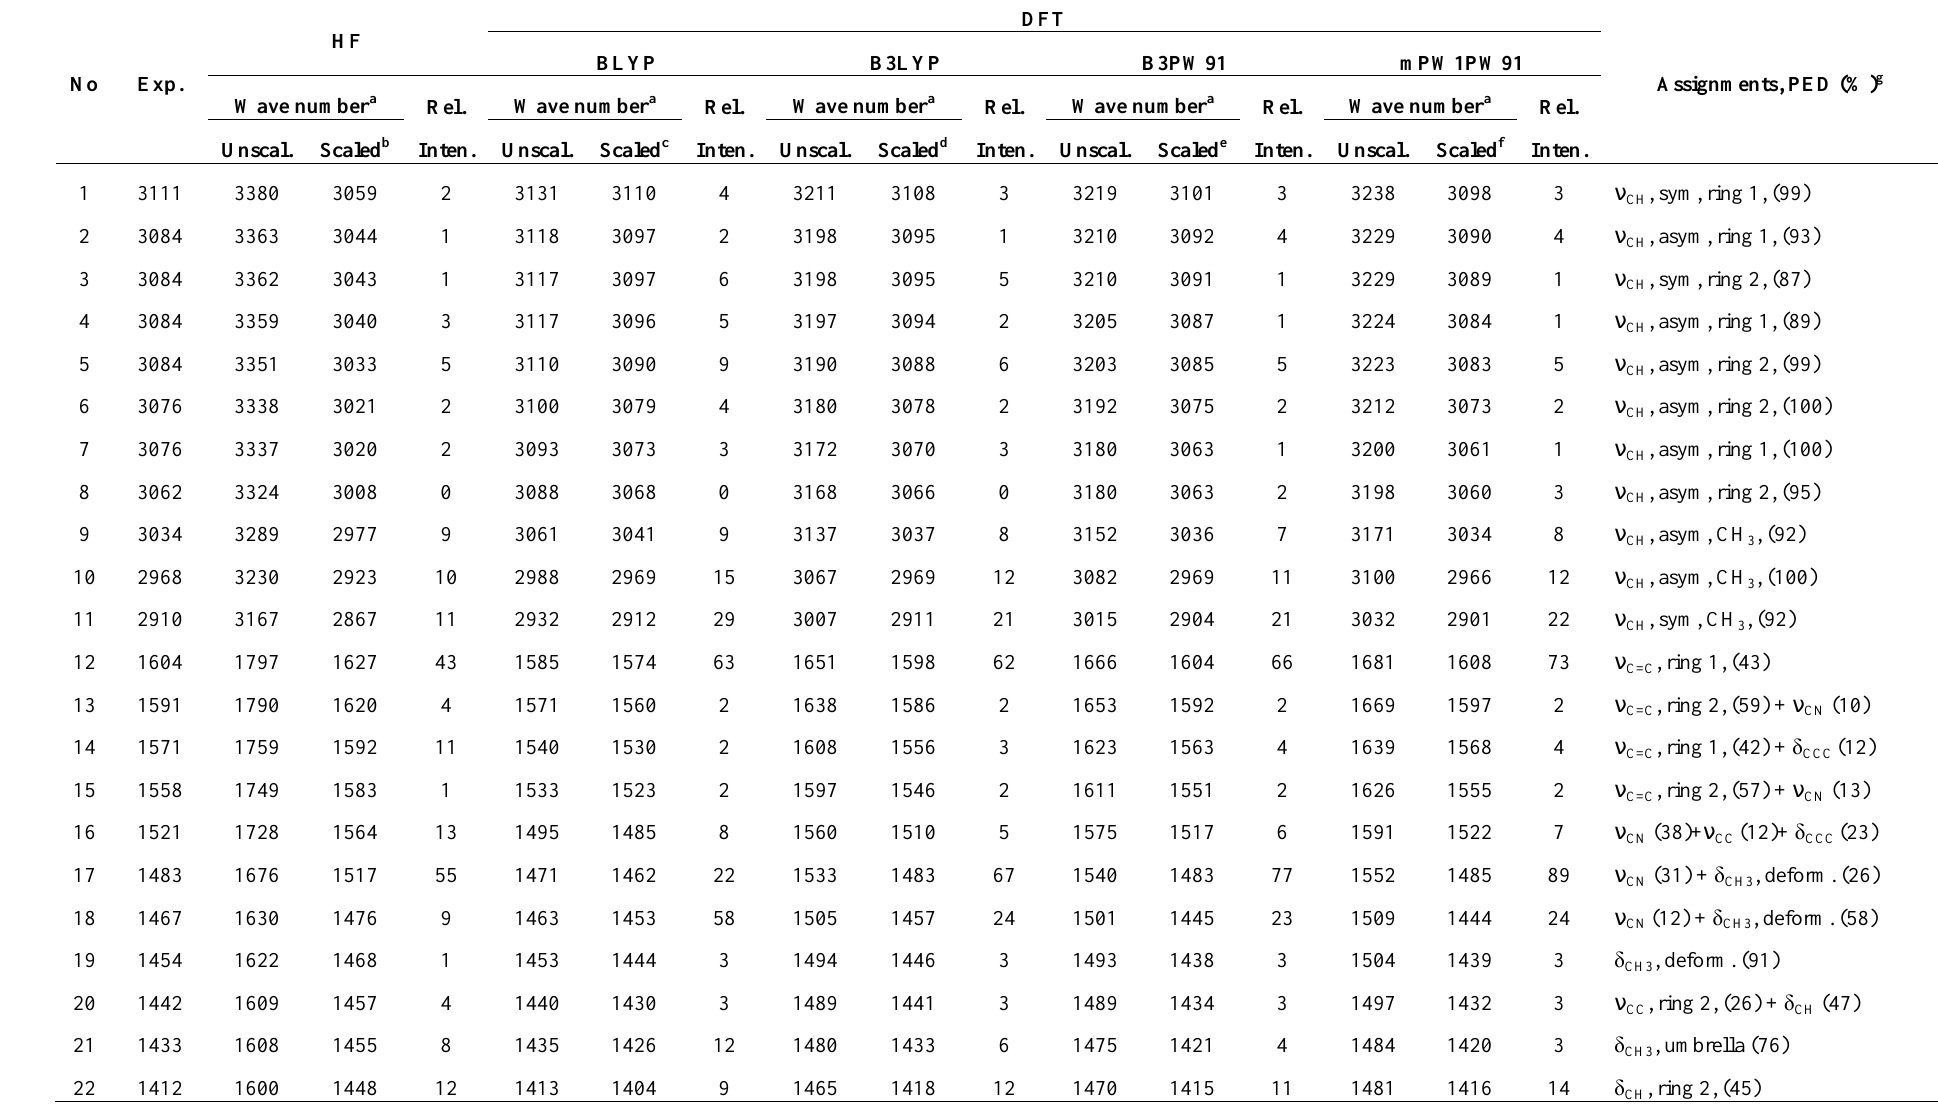
Table 3. Vibrational wavenumbers obtained for the title compound at 6-311G(d,p)